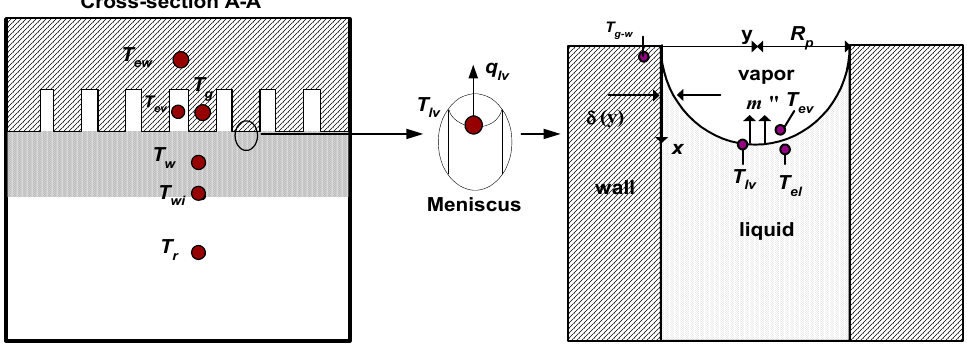
Figure 4. Phase-change phenomenon at the pore of a capillary structure [14].